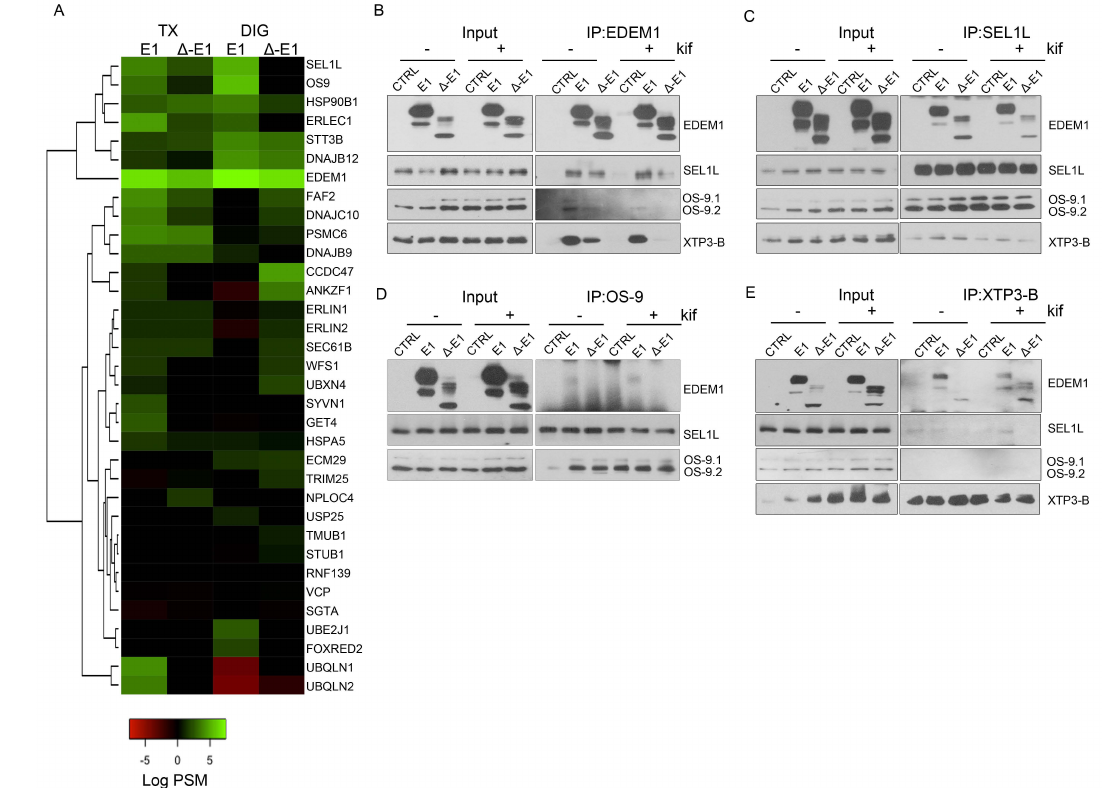
Figure 3. Association of EDEM1 and ∆ -EDEM1 with ERAD partner proteins. ( A ). Heatmap representation of proteins identified by mass spectrometry after enrichment with anti-EDEM1 antibodies from HEK293T cells overexpressing EDEM1 or ∆ -EDEM1 extracted in Triton X-100 (TX) or digitonin (DIG)-containing bu ff ers. The identified proteins were annotated with GO terms from UniProt database, and only entries that contained the ERAD key-term were further kept for analysis. The colour key denotes spectral counts (SC) in log scale after negative control (cells transfected with an empty vector and immunoprecipitated with EDEM1 antibodies) subtraction. ( B – E ). HEK293T cells were transfected to overexpress an empty vector (CTRL), EDEM1 (E1), and ∆ -EDEM1 ( ∆ -E1), and they were treated or not with 30 µ M kifunensine (kif) ON. Cells were harvested, lysed in CHAPS-containing bu ff er, and equal amounts of protein were used for immunoprecipitation with antibodies for: ( B ) EDEM1, ( C ) SEL1L, ( D ) OS-9, and ( E ) XTP3-B. The eluted resin-bound complexes were separated by